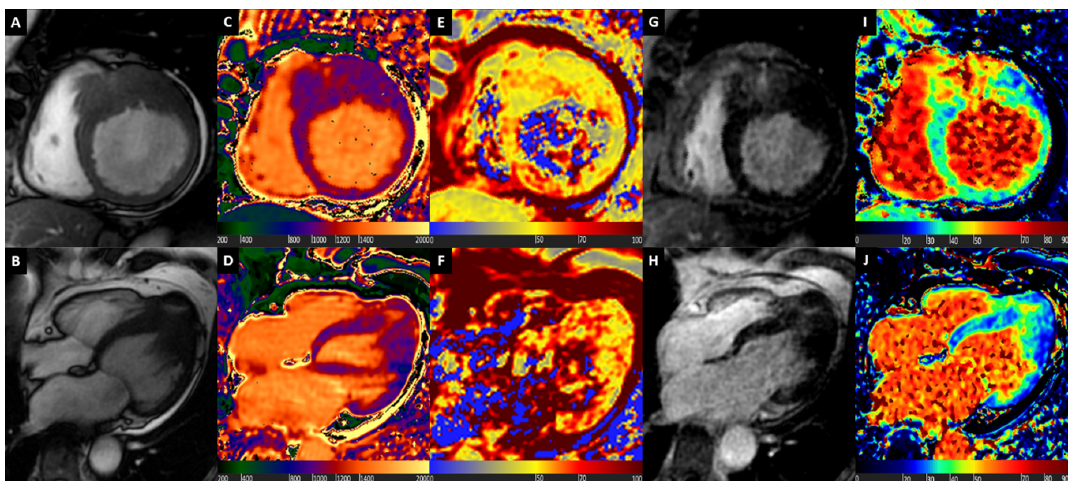
Figure 2. Hypertrophic Cardiomyopathy. Basal short axis view (Box A ) and 4-chamber long axis view (Box B ) balanced steady state free precession images showing asymmetric myocardial hypertrophy. Diffuse mild increase of T1 values at native T1 mapping images, with highest values at hypertrophied segments (Boxes C and D ). Myocardial oedema detected by T2 mapping (Boxes E and F ), mostly at septal level. LGE images show mid-wall patchy enhancement at hypertrophic segments (Boxes G and H ). Diffuse mild increase of ECV, with highest values at hypertrophied segments (Boxes I and J ).